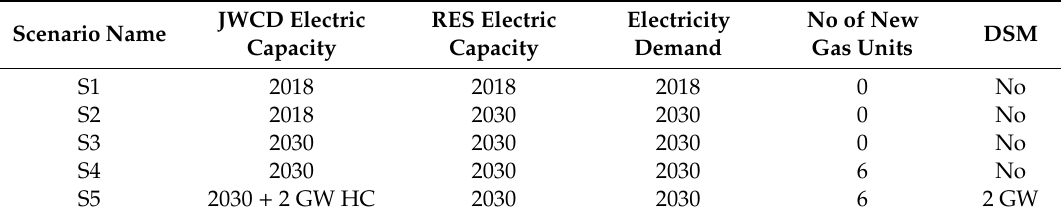
Table 6. Specification of simulation runs including reference years for the main input